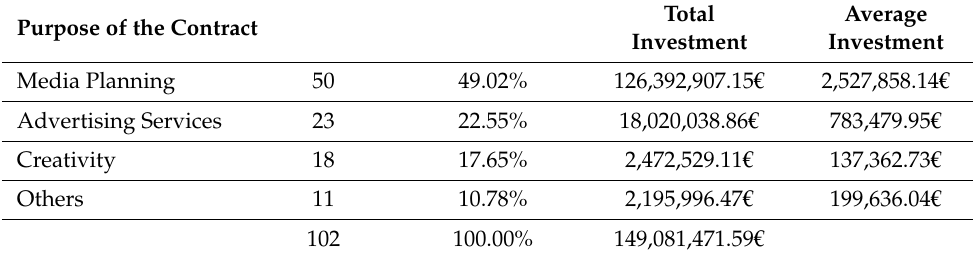
Table 1. General description of the